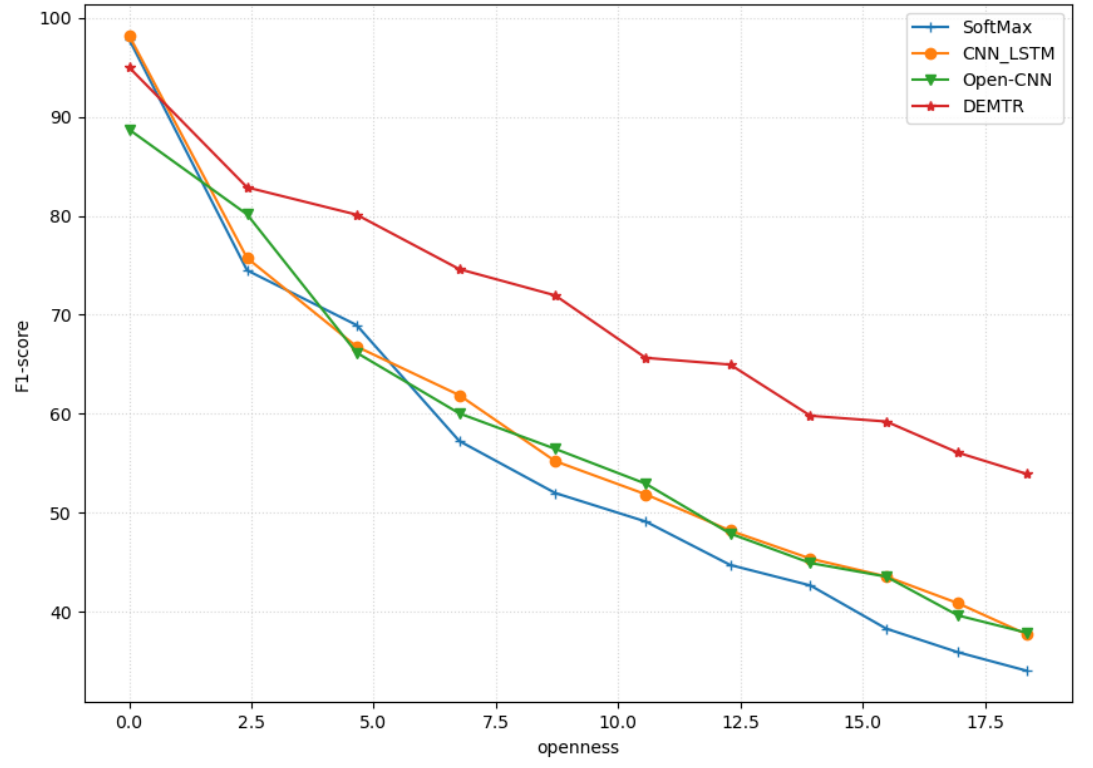
Figure 5. The relationship between F 1 -score and openness.